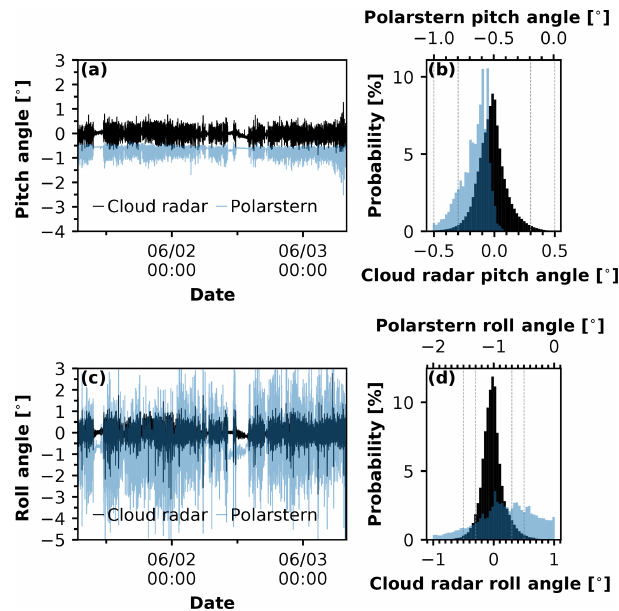
Figure 4. (a) Pitch and (c) roll of Polarstern (blue) and cloud radar (black) during the ice transit of Polarstern from 1 June 2017 07:00UTC to 3 June 2017 8:00UTC. In panels (b) and (d) the re- spective histogram is shown – note the different axes scales of the cloud radar data (bottom axis of each histogram) and Polarstern data (top axis). The dashed lines indicate a rotation angle of ± 0 . 5 ◦ and ± 0 . 3 ◦ .